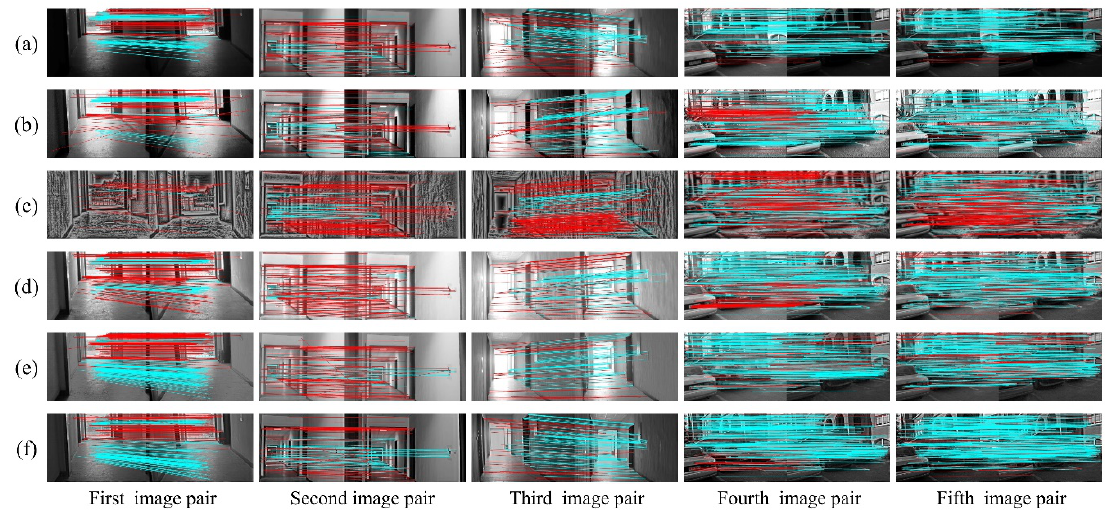
Figure 6. The visual matching performances when applying SIFT: ( a ) original images; ( b ) images transformed with HES; ( c ) images transformed with LFA; ( d ) images transformed with LIME; ( e ) images transformed with NPEA; and ( f ) images transformed with our method.